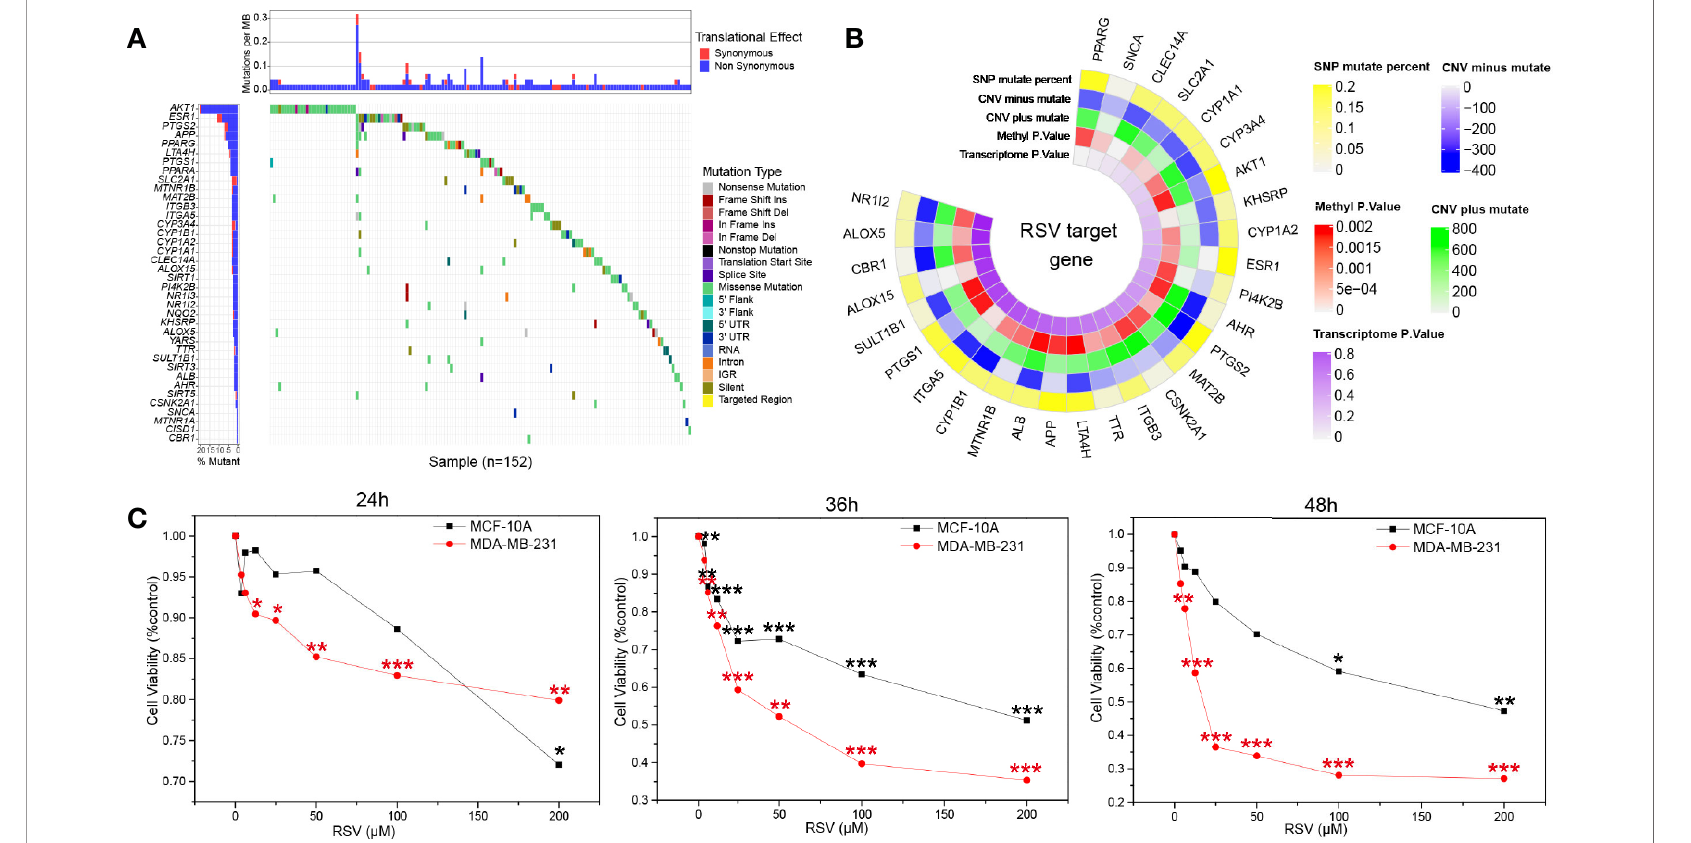
FIGURE 2 | Resveratrol treatment potential in breast cancer. (A) Waterfall map of resveratrol target in drugbank and resveratrol target domain protein in protein data bank (TCGA download breast cancer data). (B) Multiomics circplot of resveratrol target in drugbank and resveratrol target domain protein in protein data bank (TCGA download breast cancer data). (C) Resveratrol inhibited the survival of MDA-MB-231 and MCF-10A cells at different concentrations (24 h, 36 h, 48 h). *p<0.05, **p<0.01,